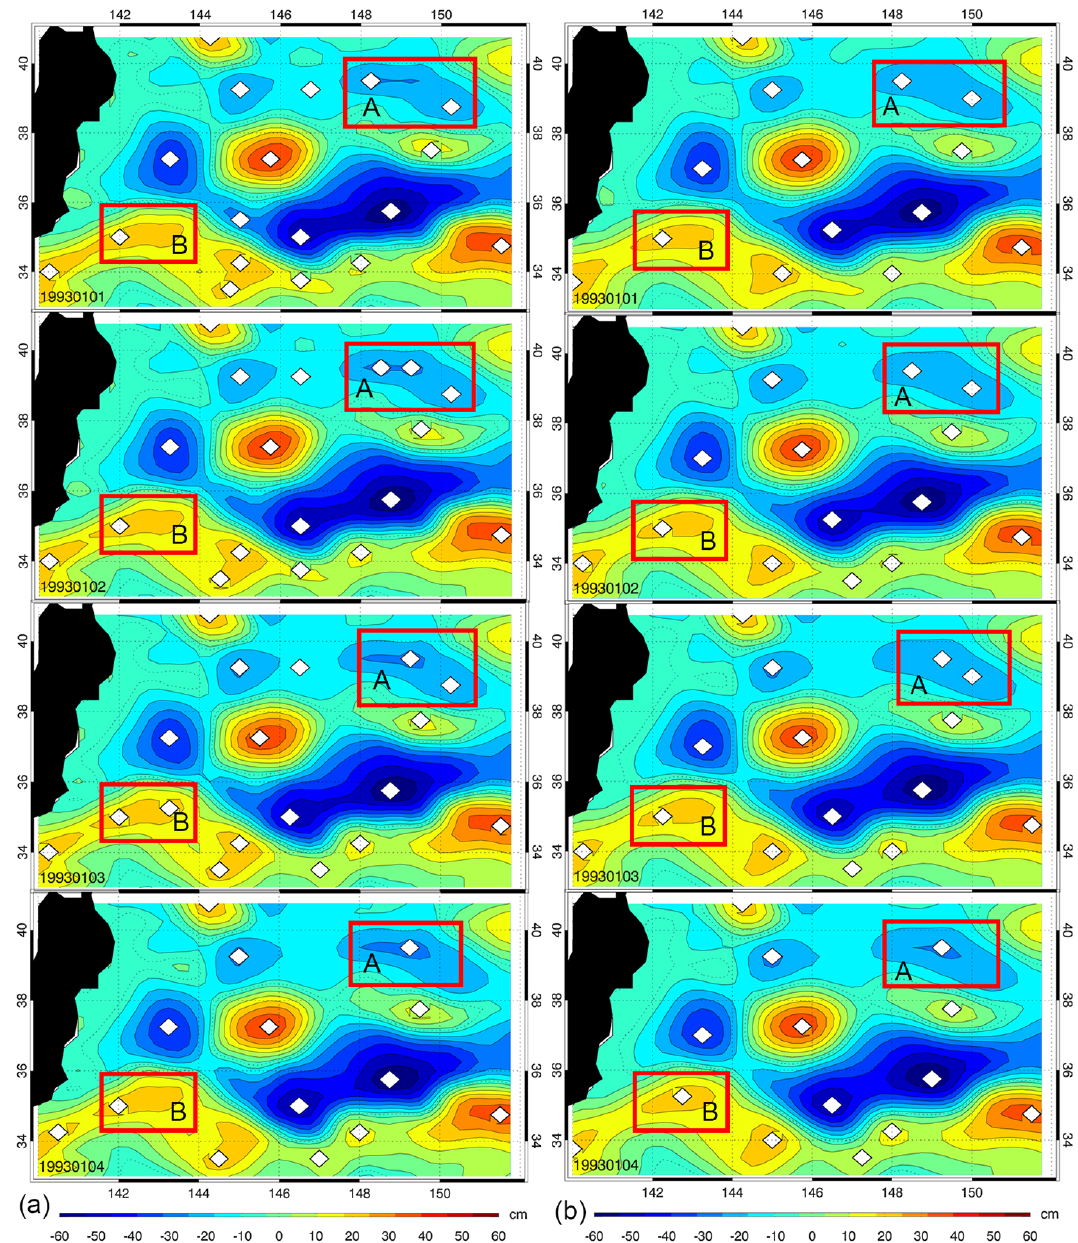
Figure 14. Comparison of the non-smoothed (a) and smoothed SLA data (b) from 1 to 4 January 1993, where the color field shows SLA, white dots mark eddy centers, and two boxes A and B mark the regions sensitive to noise. Note that small noise affected the eddy